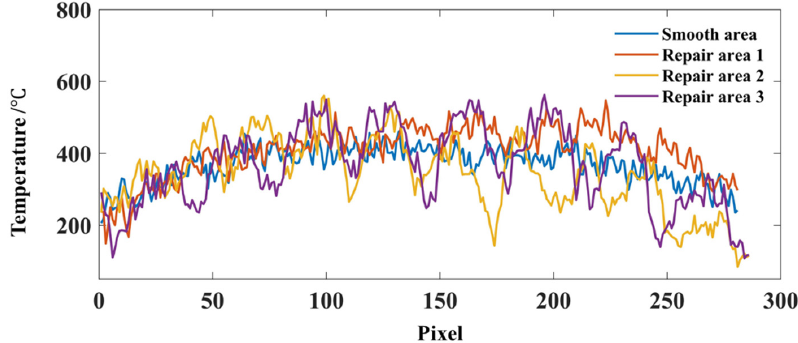
Figure 21. Temperature distribution of several different measured surfaces along a line L 1 .